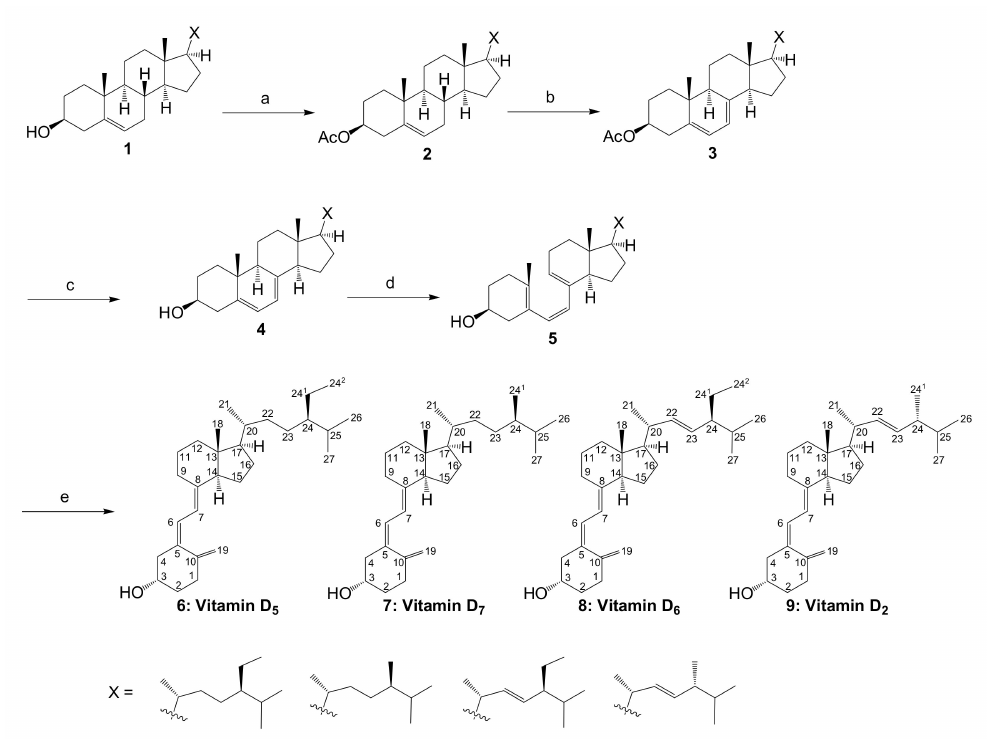
Figure 2. Reagents and conditions. ( a ) Ac 2 O, pyridine, 45 ◦ C, 15 h, 98%. ( b ) ( 1 ) N -bromosuccinimide (NBS), cyclohexane, reflux, 1 h, ( 2 ) 1.0 M Bu 4 NF / THF, room temperature, 12 h, 45%. ( c ) 28% NaOMe in MeOH, CH 2 Cl 2 / MeOH, room temperature, 2 h, 77%. ( d ) 0.1% 3- tert -butyl-4-hydroxyanisole (BHA) in cyclohexane, 280 nm, 9.03 mW / cm 2 , room temperature, 4 h, 28%. ( e ) 0.1% BHA in cyclohexane, reflux, 1 h, 39% {It was calculated from the total weight (20.8 mg) of the obtained vitamin D analogs, including vitamin D 4 .}.